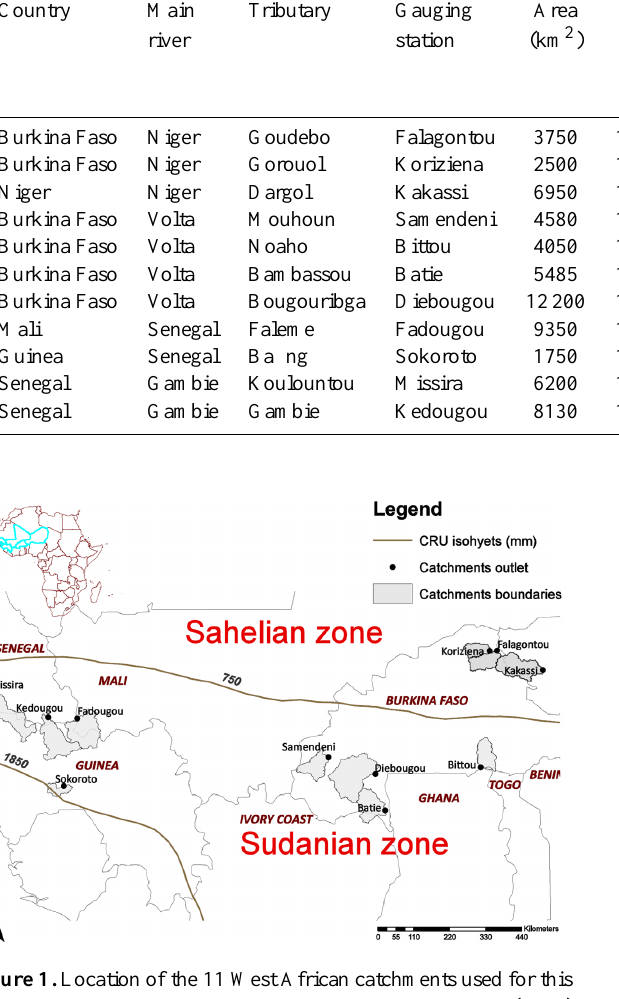
Figure 2. Mean monthly hydrograph for Kakassi (Sahelian